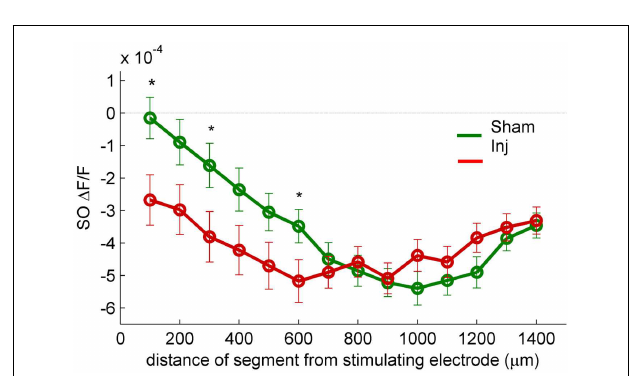
FIGURE 3 | SR-evoked SO hyperpolarization is larger near the stimulating electrode in slices prepared from injured mice .VSD single segment average SR-evoked hyperpolarization in SO and proximal SP as a function of distance from the stimulating electrode. Asterisks indicate significant difference between sham and injured slices in the indicated segments (Mann–Whitney P < 0.05). Individual segments 1, 3, and 6 were significantly different, as was the average of segments 1 through 6. None of the individual segments 7 or higher were significantly different between sham and injured.These results are consistent with the hypothesis that the increased SO hyperpolarization after injury is due to an increase